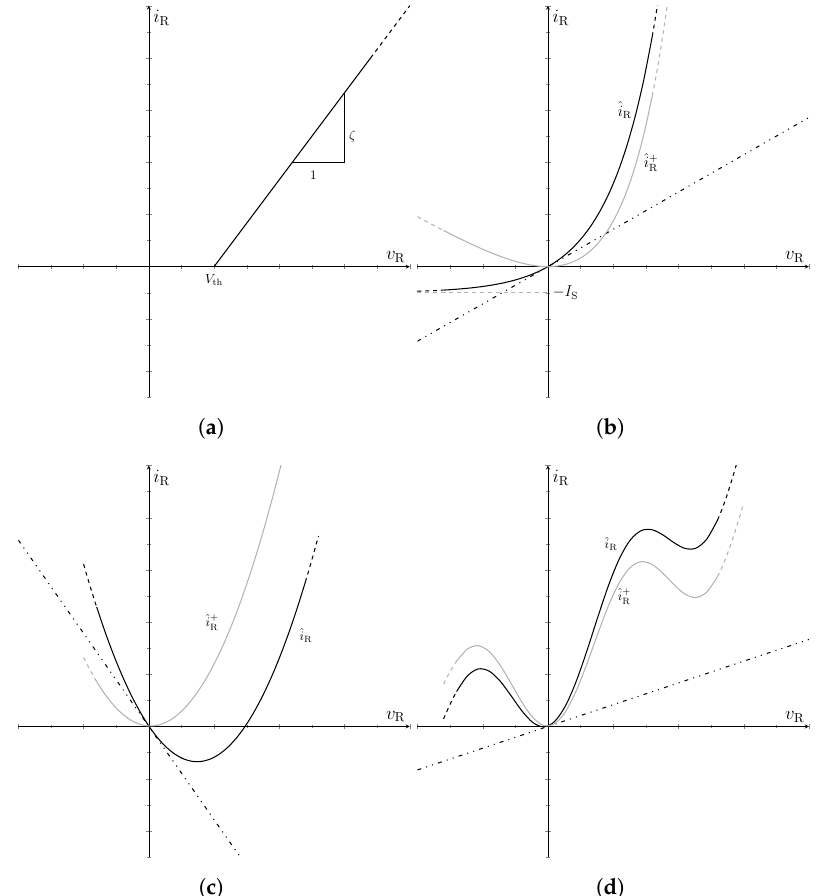
Figure 2. Characteristics of ˆ i R for a nonlinear voltage-controlled resistor. ( a ) PWL diode satisfying Assumption 1. ( b ) Exponential characteristic of a Shockley diode satisfying Assumption 2; the drawing also shows the tangent to ˆ i R at v R = 0 (dashed–dotted) and the function ˆ i + ( c ) Characteristic with a negative slope at v R = 0 satisfying Assumption 2 and ( d ) non-monotone characteristic satisfying Assumption